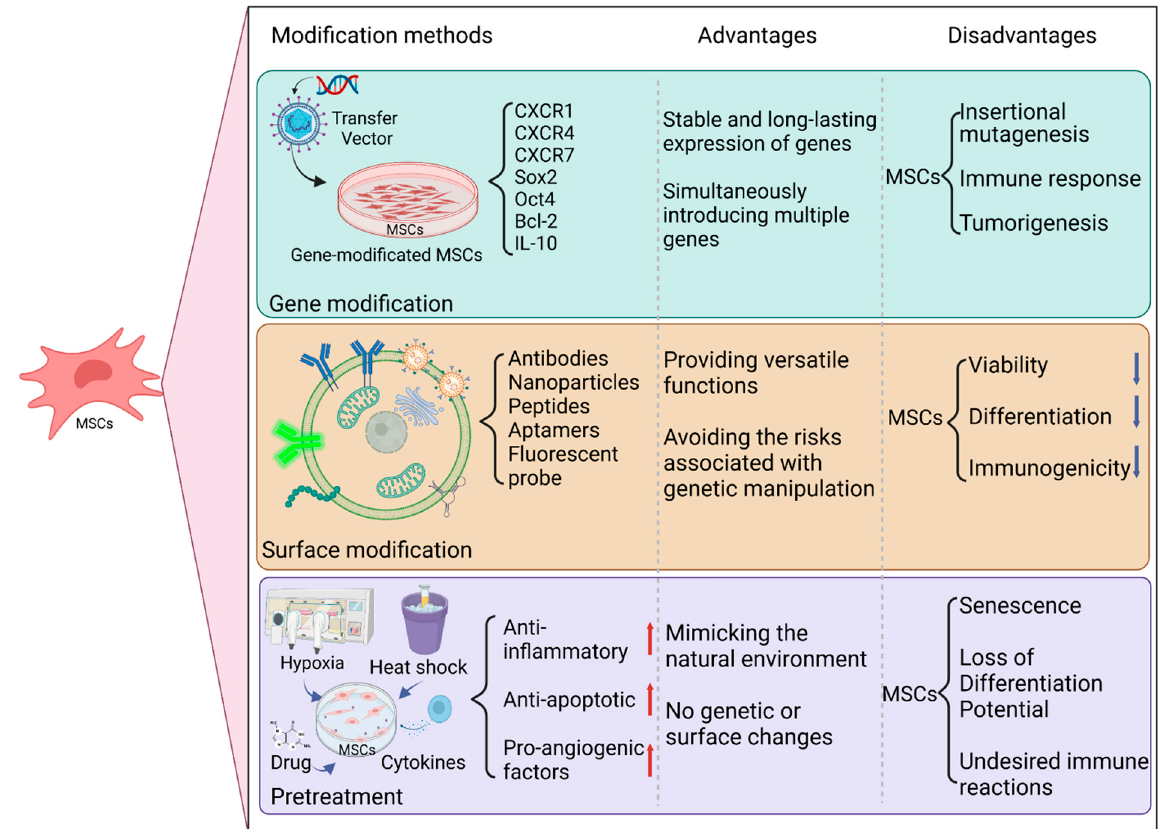
Figure 2. The various methods employed to modify mesenchymal stem cells (MSCs) for therapeutic applications, such as gene modi fi cation, surface modi fi cation, and pretreatment. Each method can a ff ect the therapeutic e ff ect and safety of MSCs di ff erently, and the advantages and disadvantages of each must be evaluated based on the speci fi c application and disease